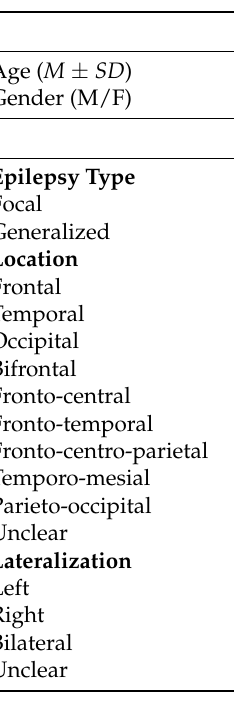
Table 1. Descriptive information on demographic and